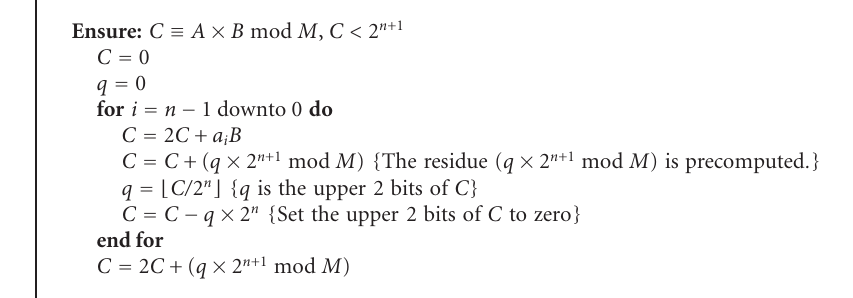
Algorithm 4: Tomlinson’s sum of residues modular